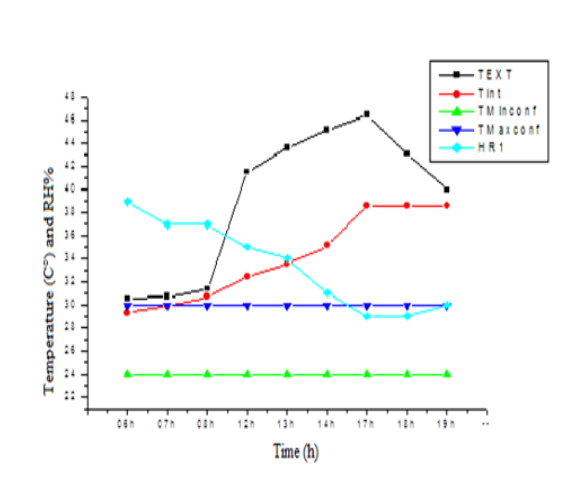
Figure 15. Variation of the internal and external temperatures during the